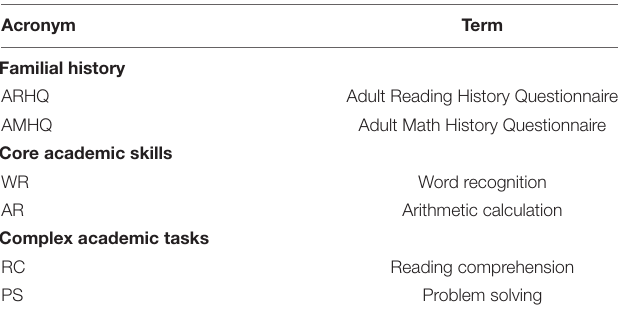
TABLE 1 | List of abbreviations used throughout the current